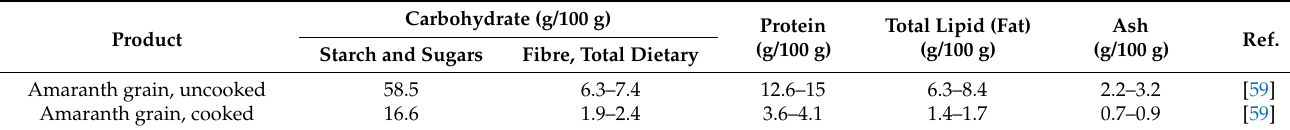
Table 6. Basic ingredients of amaranth product per 100 g.